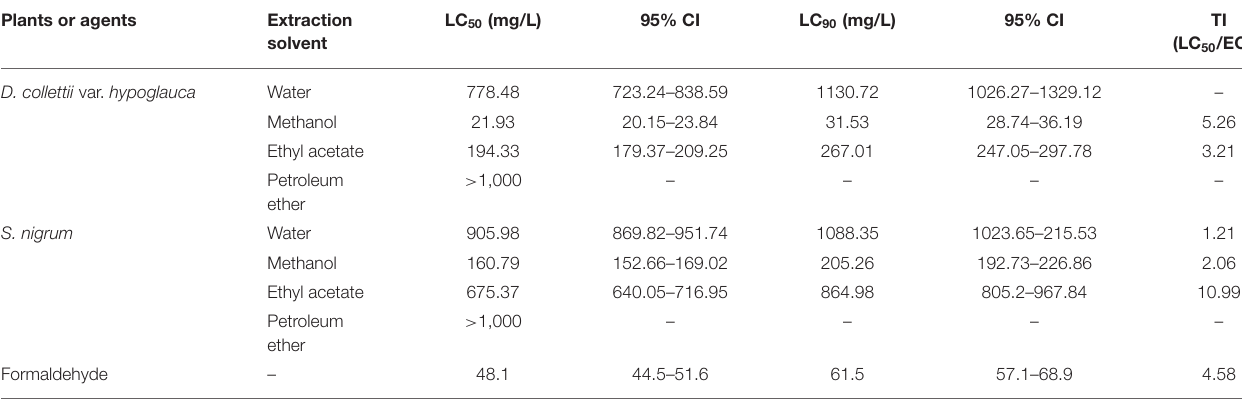
TABLE 3 | Acute toxicity of different extracts from Dioscorea collettii var. hypoglauca and Solanum nigrum against goldfish after 48h of exposure. Plants or agents